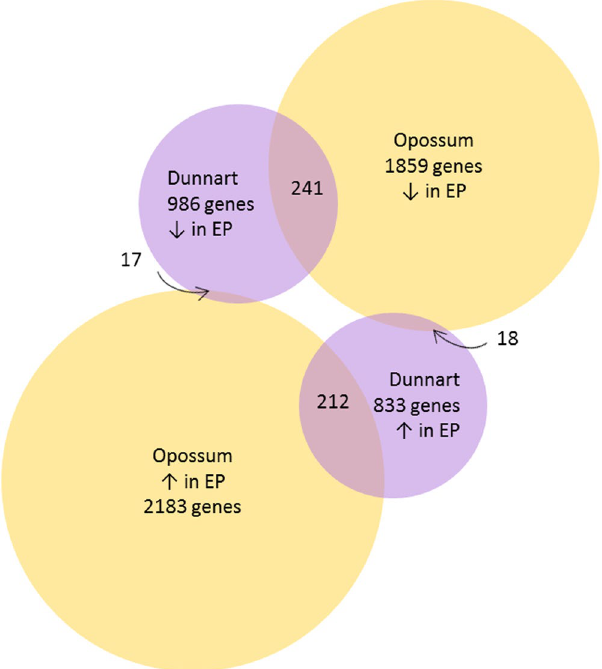
Figure 1. Venn diagram indicating the differentially expressed genes between opossum pre-implantation pregnant and non-pregnant uterus that are also differentially expressed in dunnart pre-implantation pregnancy. EP = early/pre-implantation